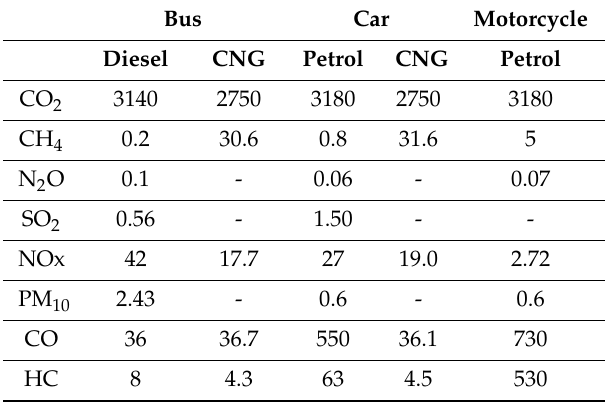
Table 6. Emission factors for the different vehicle types in Tehran (g/kg fuel ).